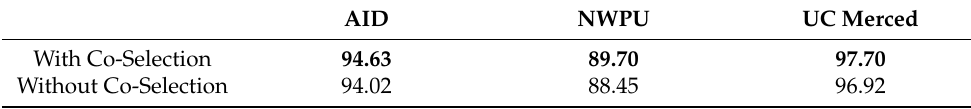
Table 8. Ablation study of the proposed method on the three data